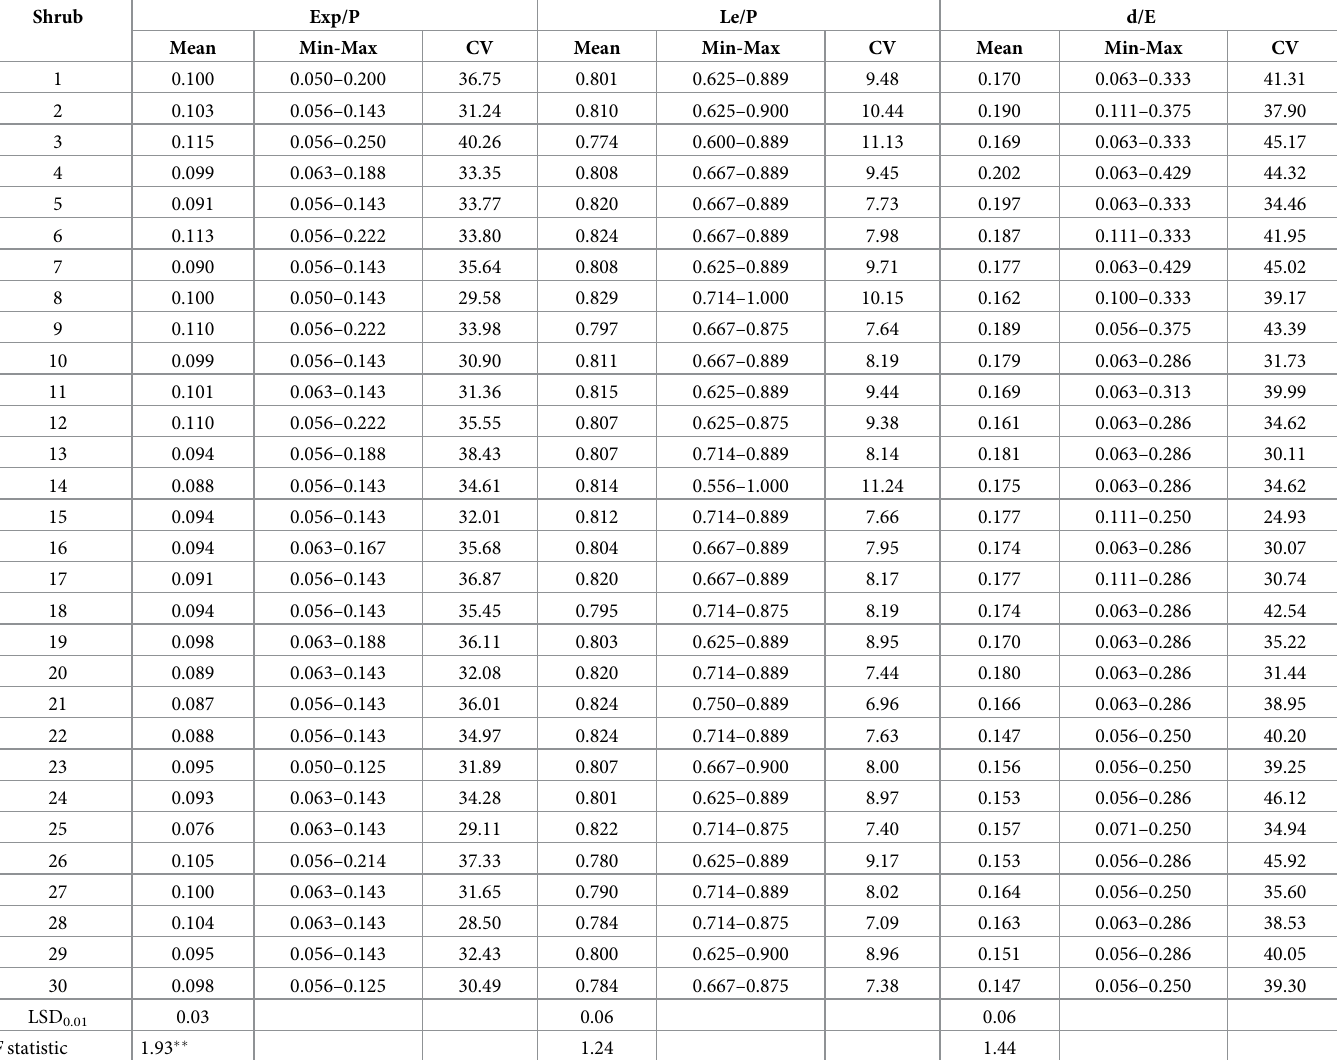
Table 4. Minimal, maximal and mean values as well as coefficients of variation (CV) for Exp/P, Le/P and d/E ratios of